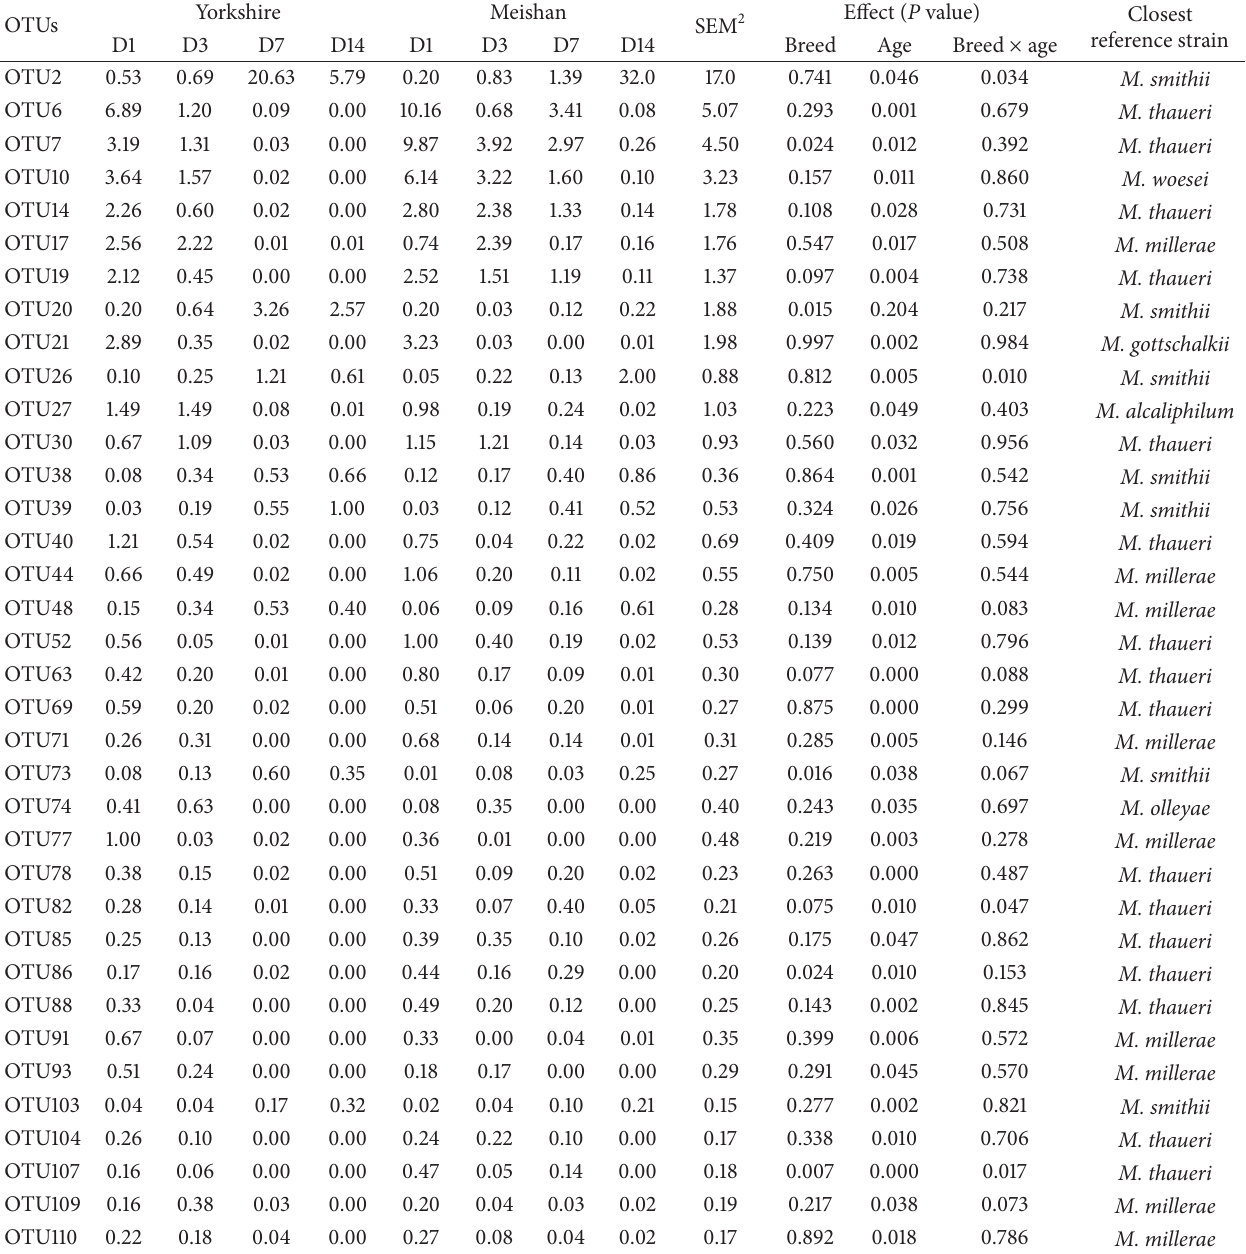
Table 2: Relative abundances of predominant OTUs (percentage) in the 16S rRNA gene libraries from faecal methanogens of Meishan and Yorkshire piglets 1